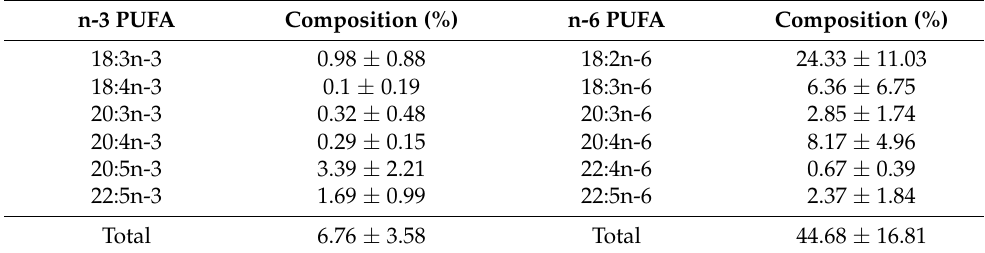
Table 3. Proportions of PUFA